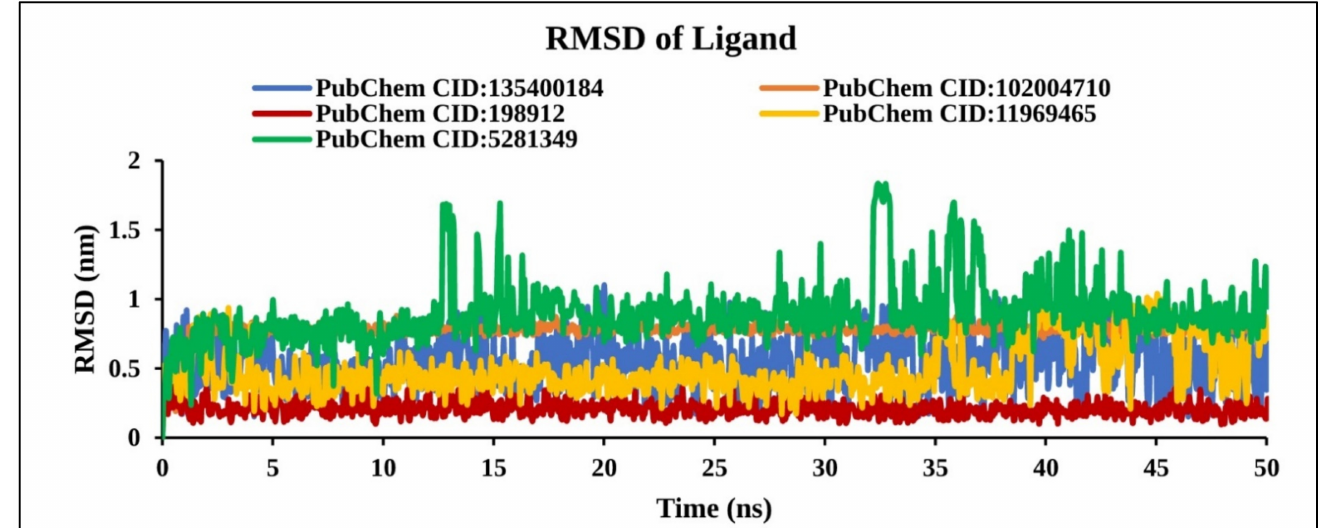
Figure 10. Line graph showing RMSD values of the complex structure extracted from ligand atoms viz: PubChem CID: 135400184 (blue); PubChem CID: 198912 (dark red); PubChem CID: 5281349 (green); PubChem CID: 102004710 (orange); and PubChem CID: 11969465 (yellow) to 50 ns simulation